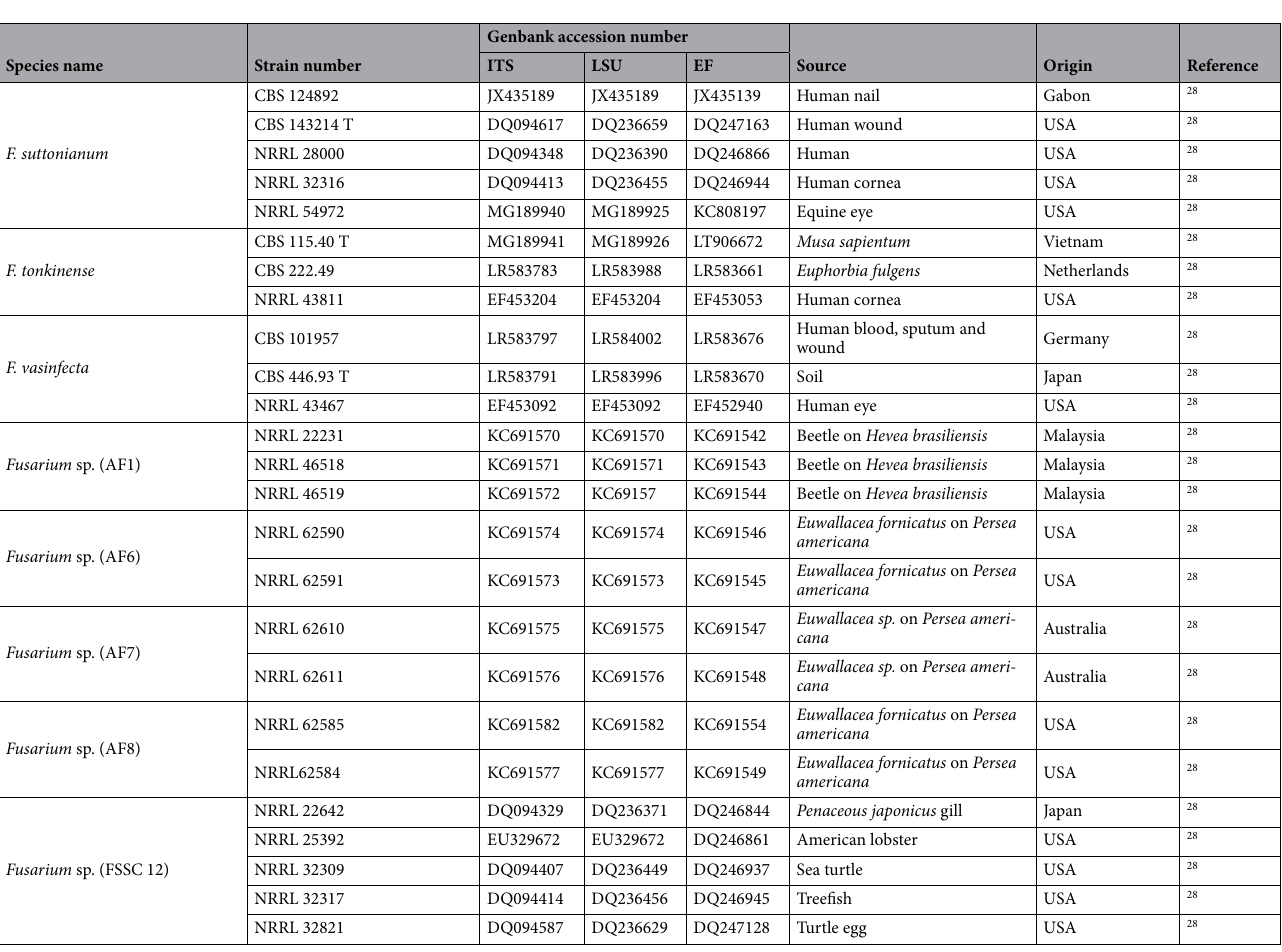
Table 2. Fusarium strains included in the phylogenetic